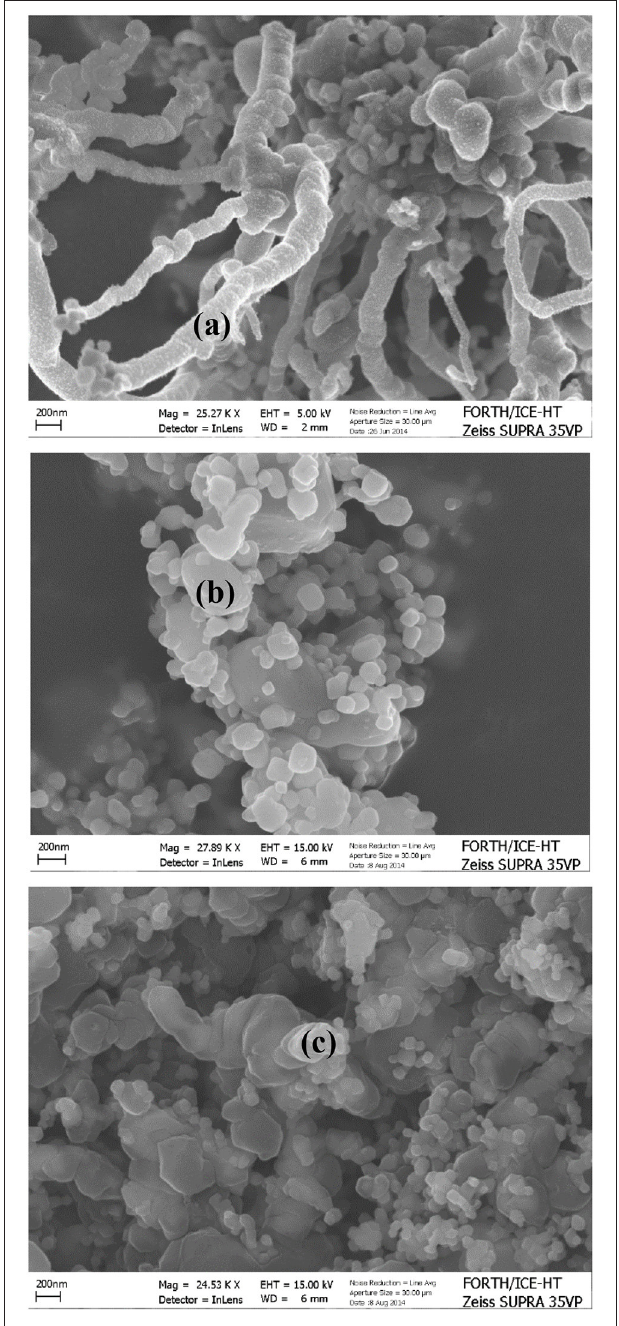
FIGURE 9 | SEM images after the in situ XRD with 1 vol.% CH 4 /N 2 of: (A) Ni/GDC, (B) 3Au-Ni/GDC, (C) 3Au-3Mo-Ni/GDC. Reprinted with permission from Neofytidis et al. (in